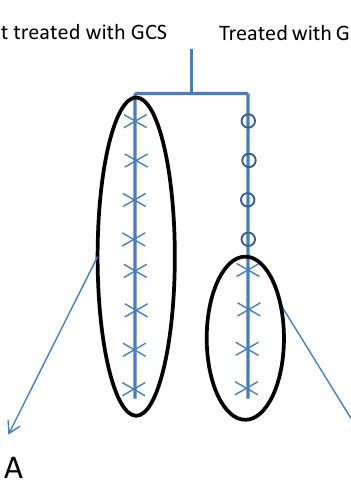
Figure 6. Linked to Table 5 (4rd model). The fourth model compared patients who received GCS treatment during their ICU stay on their "steroid-free days" to those who were never treated with